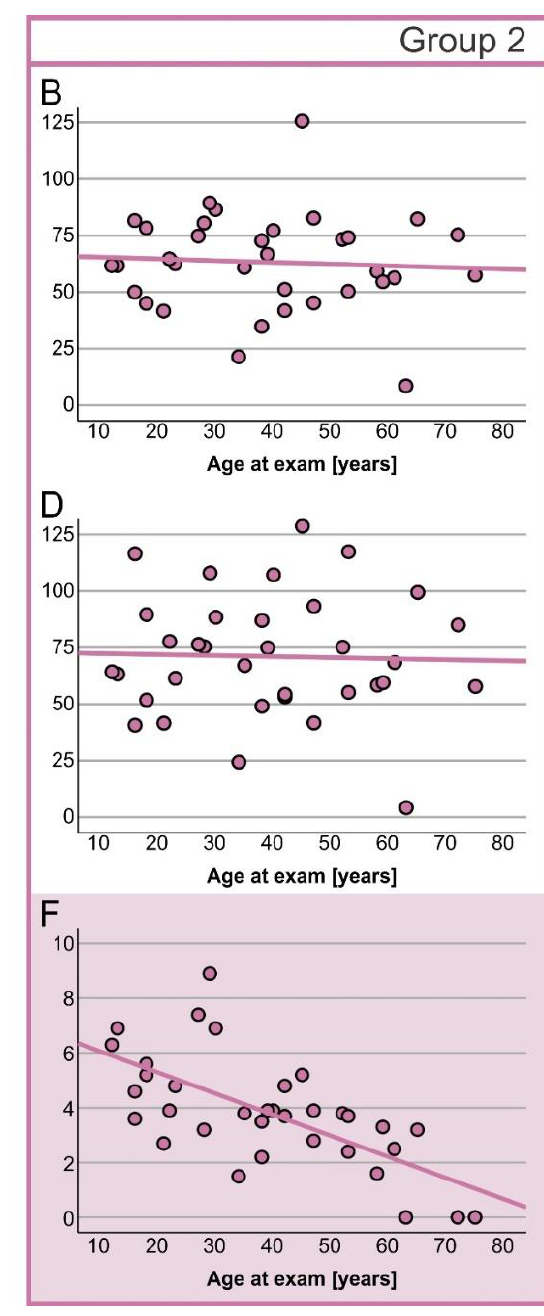
Figure 4. Age − dependent decrease (linear regression) in LA ERG responses in Group 1 ( A , C , E ) and 2 ( B , D , F ) patients. Group 1 is marked with green and Group 2 with purple. The purple − colored graph represents a significant correlation between age and S − cone ERG amplitude.